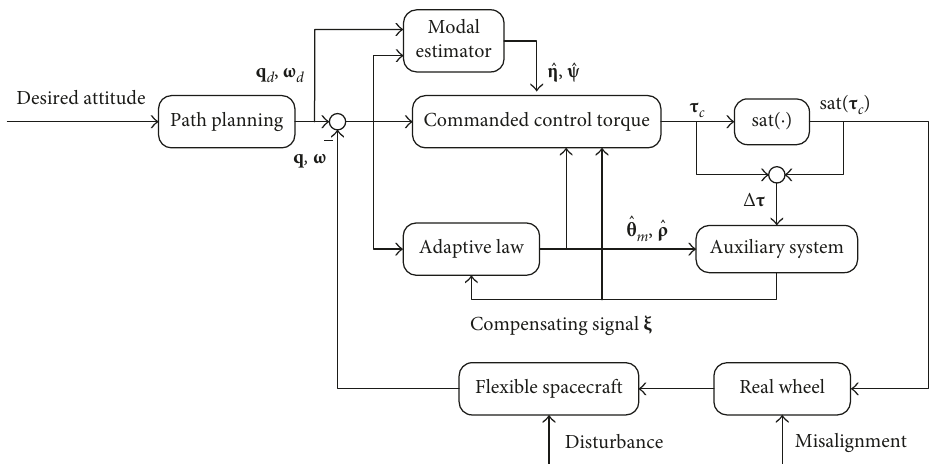
Figure 1: Structure of the closed-loop